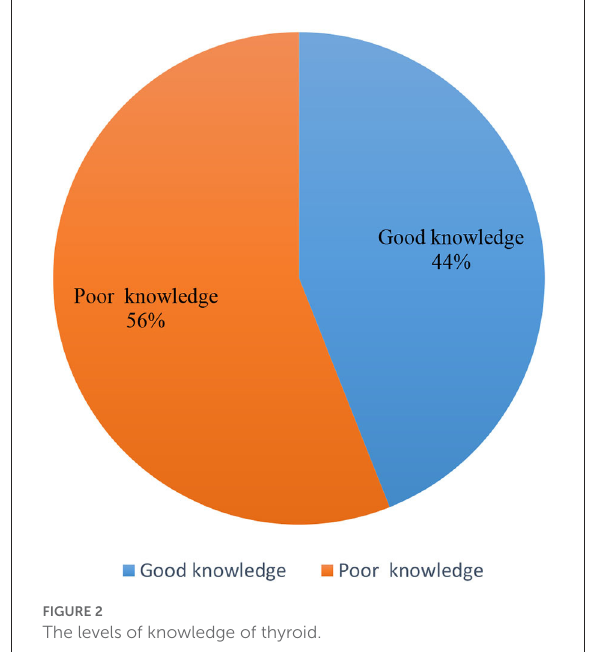
FIGURE2 The levels of knowledge of